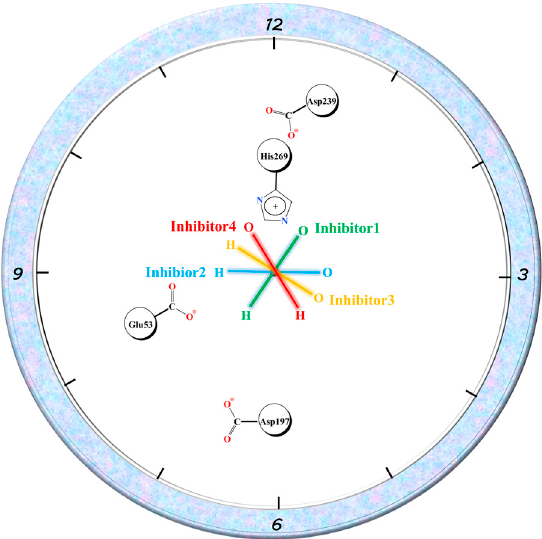
Figure 12. Schematic diagram of Glu53, Asp197, Asp239, and His269 residue positions and amide bond directions, where the C-N bond in the amide bond is used as the axis and is oriented perpendicular to the paper plane.